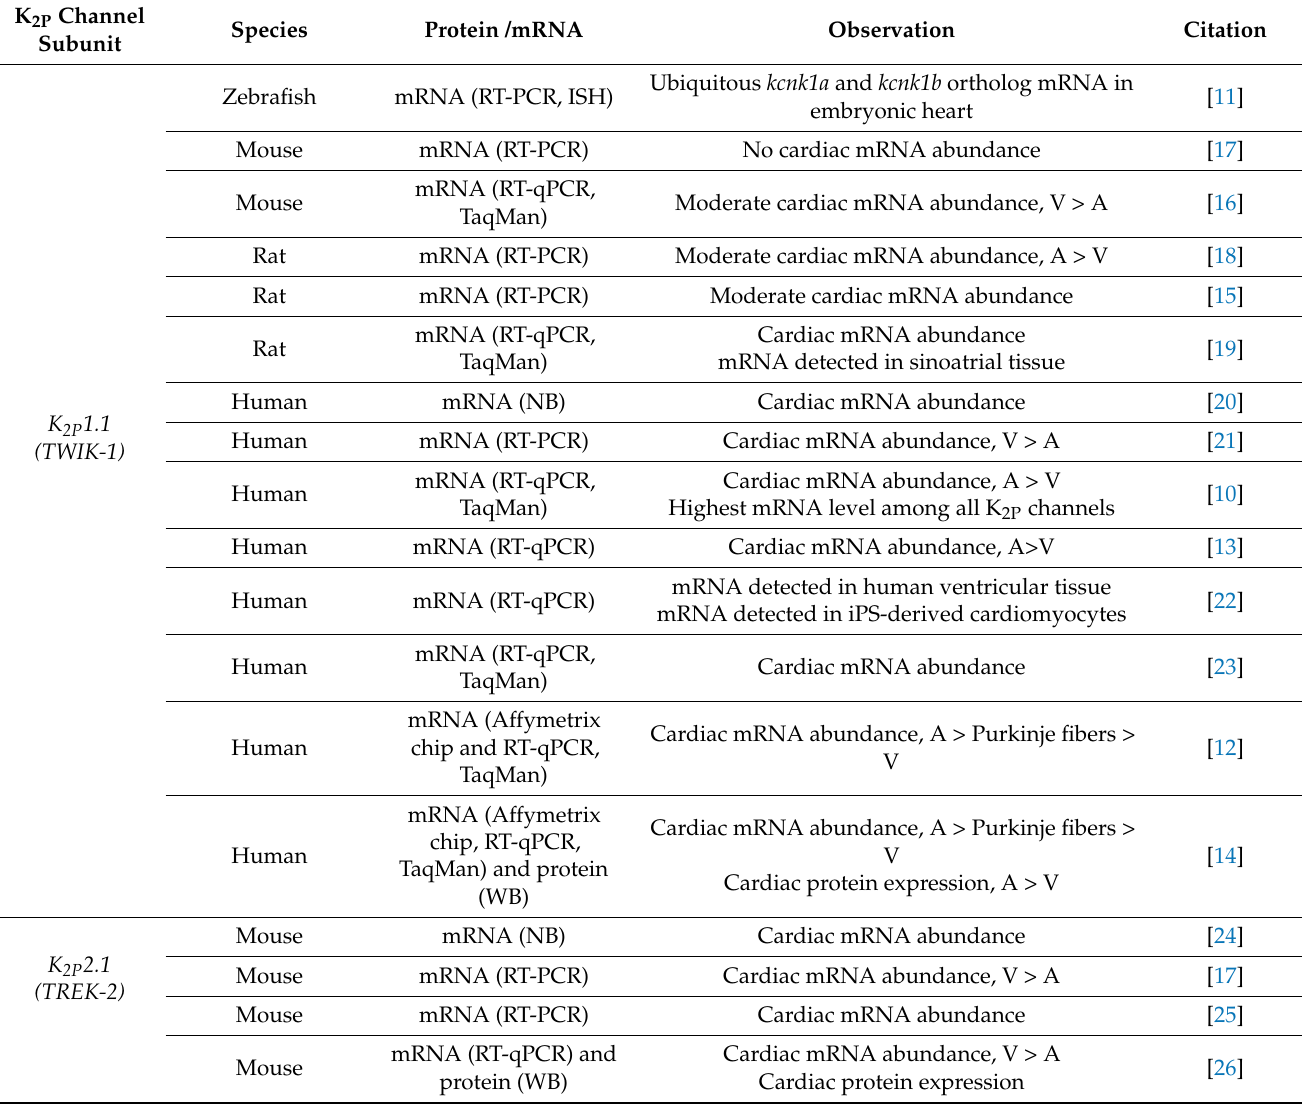
Table 2. Evidence in literature for cardiac expression of K 2P channel subunits at mRNA or protein level in different species. K 2P